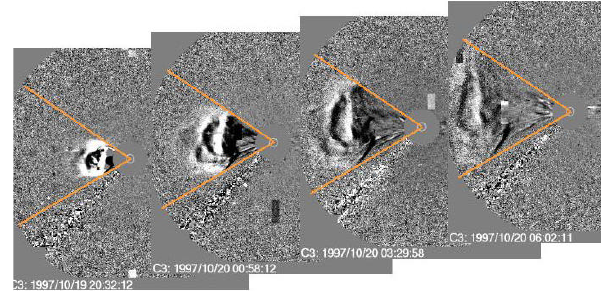
Fig. 5. Self-similarity of CMEs: the limb CME of 19 October 1997 is a typical example showing how well the opening cone angle and the general shape of a CME are maintained, at least up to 32R s . The term “cone angle” denotes the angle between the outer edges of opposing flanks of limb CMEs. It would amount to 65 ◦ in this case. The images are running differences between LASCO-C3 images.